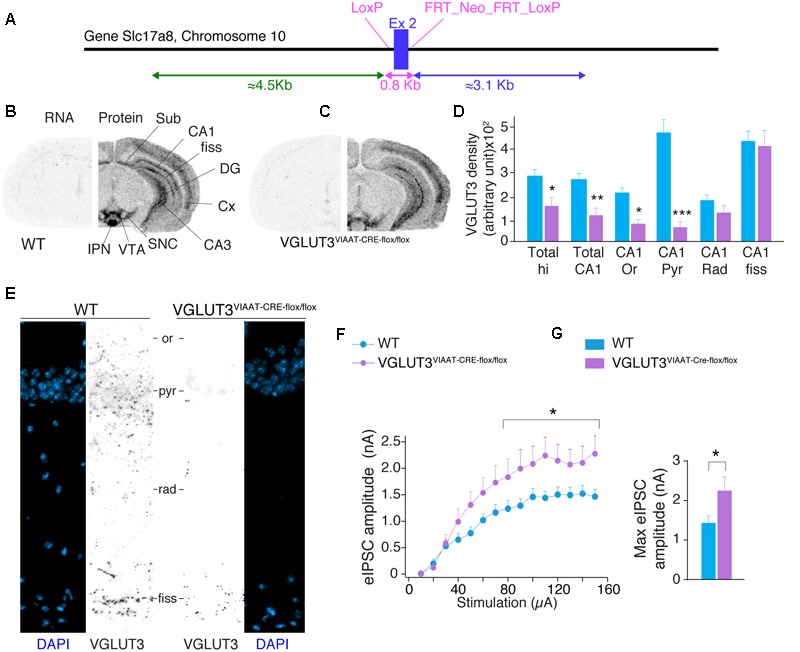
VGLUT3-dependent glutamate that regulates GABAergic synaptic transmission originates from GABAergic hippocampal interneurons. (A) Targeting strategy of the vglut3 gene locus to obtain VGLUT3flox/flox mouse line. LoxP sites flank exon 2. FRT sites flank the positive selectable marker, TK-neomycin. VGLUT3flox/flox mice were bred with VIAAT-CRE mice. VGLUT3 expression in WT mice (B) and VGLUT3V IAAT-Cre-flox/flox mice (C). VGLUT3 mRNA detected by in situ hybridization is shown on the left coronal hemi-section whereas, the protein detected by immunoautoradiography is shown on the right hemi-section. Note the selective ablation of VGLUT3 mRNA in cortical and hippocampal interneurons from VGLUT3V IAAT-Cre-flox/flox mice. (D) Quantification of VGLUT3 protein density in the hippocampus, CA1 and its subregions in WT (n = 5) and VGLUT3V IAAT-Cre-flox/flox (n = 5) mice. (E) VGLUT3 immunofluorescence (in black) and nuclei stain with DAPI (blue) in the CA1 region of the hippocampus in WT mice (left panels) and VGLUT3V IAAT-Cre-flox/flox mice (right panels). (F) Input–output curve showing that evoked GABAergic synaptic transmission increased when VGLUT3 expression is selectively suppressed in GABAergic interneurons. (G) Histogram showing that the averaged maximal eIPSC obtained at the plateau phase of the curve is significantly increased in VGLUT3V IAAT-Cre-flox/flox mice (n = 10) compared with their WT littermates (n = 10). ∗P < 0.05, ∗∗P < 0.01, ∗∗∗P < 0.001. Abbreviations: Cx, cerebral cortex; DG, dentate gyrus; fiss, hippocampal fissure; IPN, interpeduncular nuclei; Or, stratum oriens; Pyr, stratum pyramidale; Rad, stratum radiata; SNC, substantia nigra pars compacta; Sub, subiculum; VTA, ventral tegmental area.